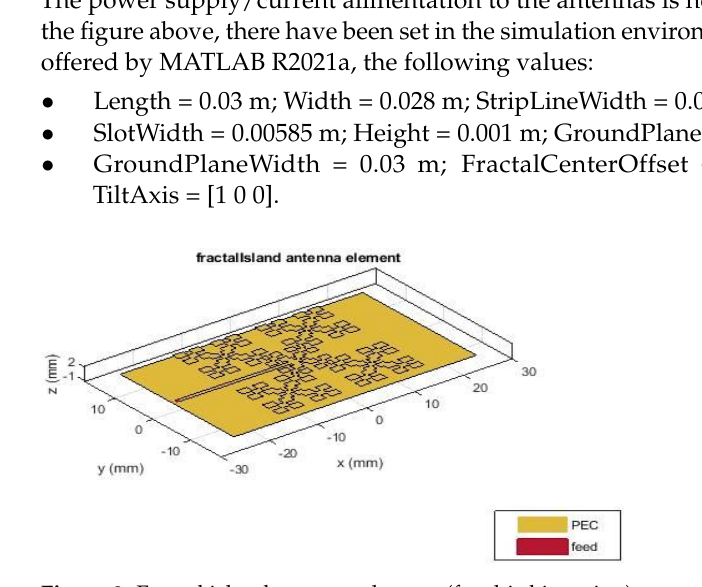
Figure 3. Fractal island antenna element (for third iteration).